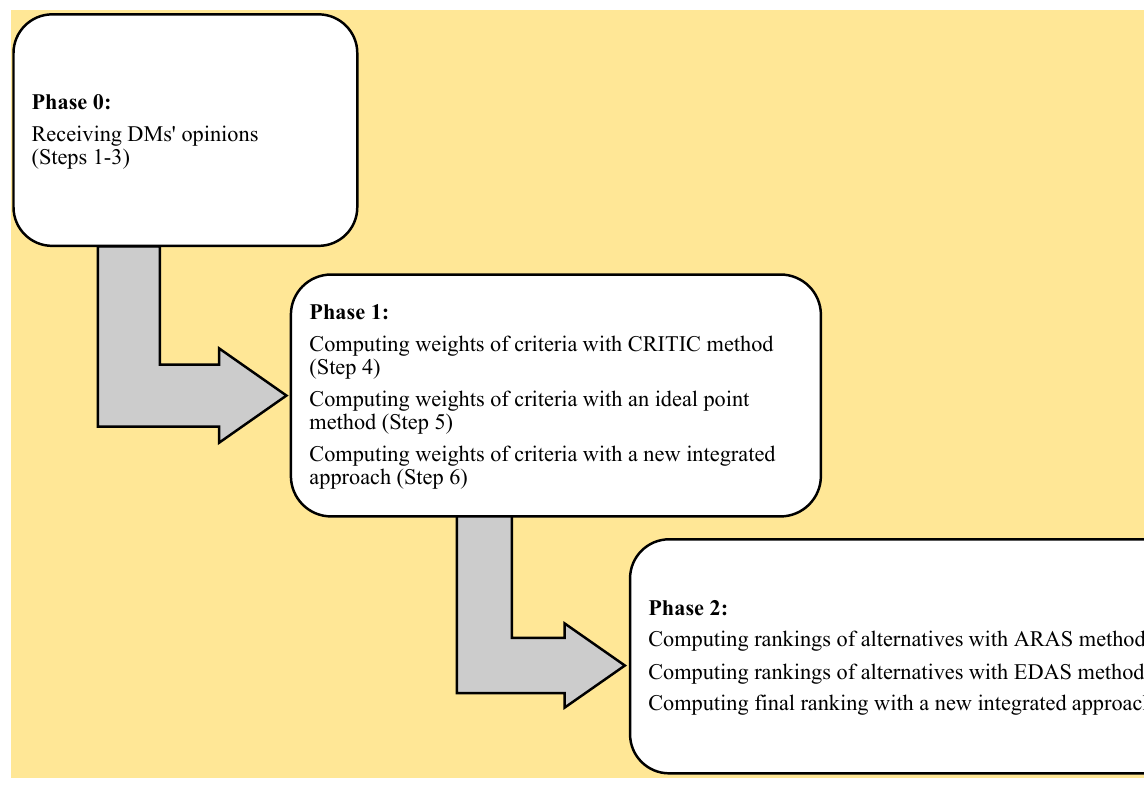
Figure 1. Structure of the introduced model.